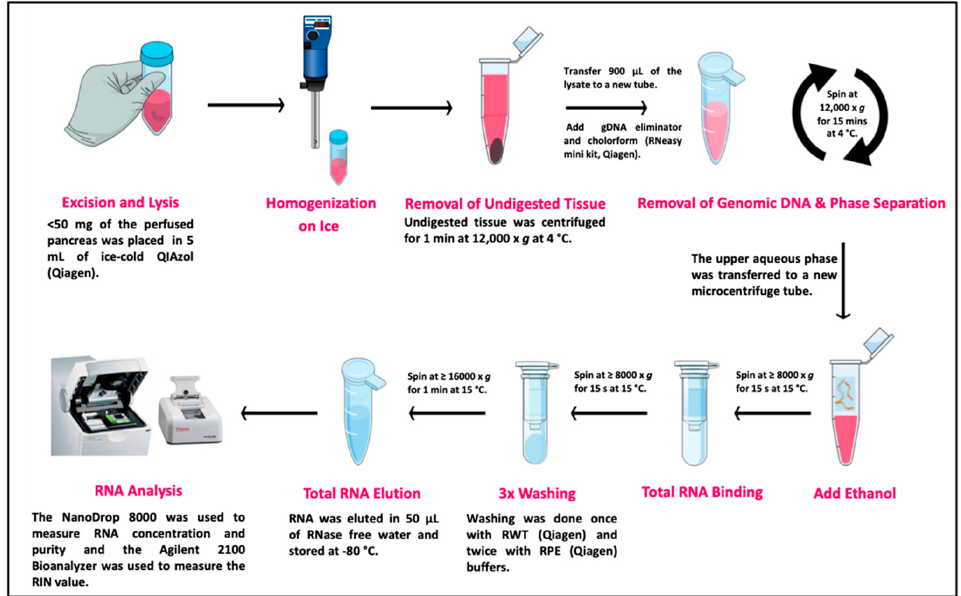
Figure 2. The optimized RNA extraction protocol workflow. The diagrams in the figure were generated using mindthegraph.com, accessed on 21 April 2022. RIN, RNA integrity number.